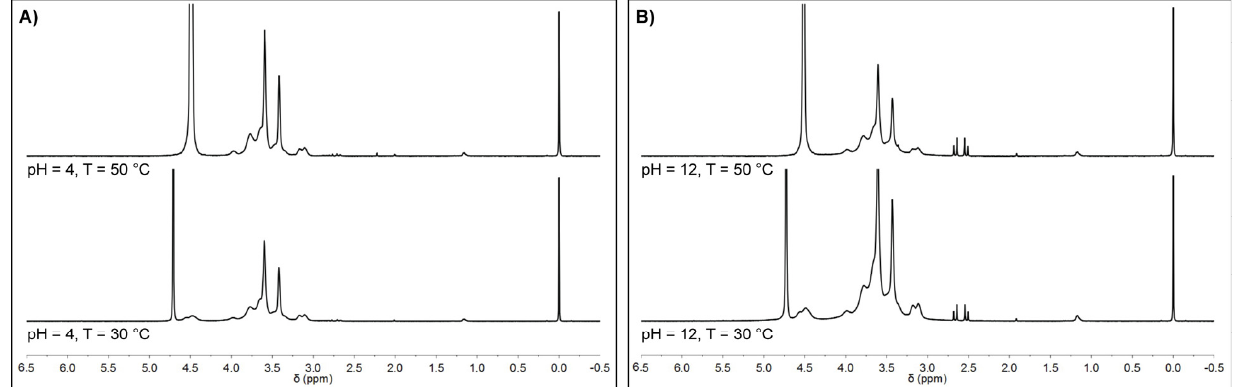
Figure 5. ( A ) 1 H-NMR spectrum of MC-H swelled at ( A ) pH = 4 and ( B ) at pH = 12, as function of temperature (30 vs. 50 °C).